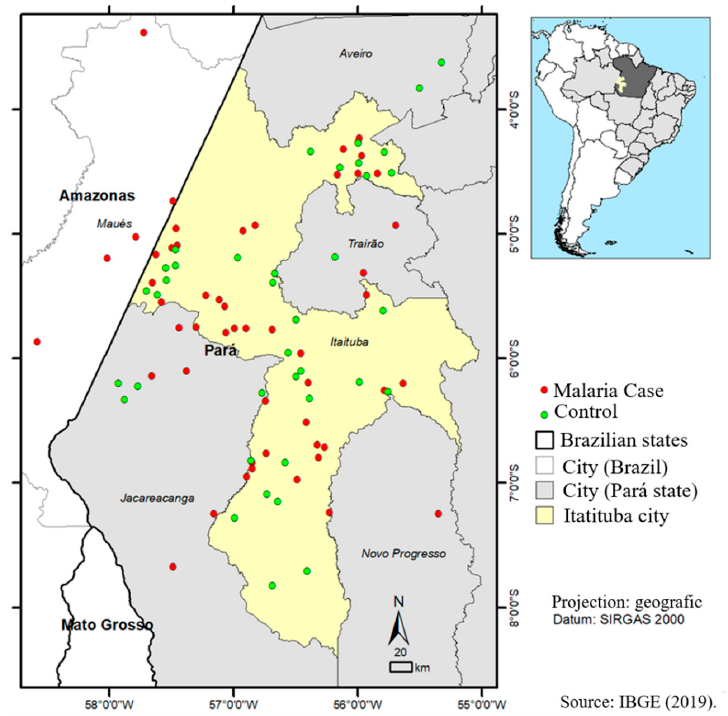
Figure 1. Distribution of malaria cases and control cases in the municipality of Itaituba-Pará. The EDK and SaTScan applications revealed the presence of one high-risk cluster and three other low-risk clusters for malaria transmission in the city of Itaituba, Pará. The high-risk localities were Flona Amana (Pista, Salto, CVA, Garimpinho and Cara Preta) and Porquinho. SaTScan identified a significant cluster ( p -value = 0.00014) with a radius of 214.6 km and a relative risk of 1.32 at the same location as the high-risk cluster identified using the EDK (Figure 2).